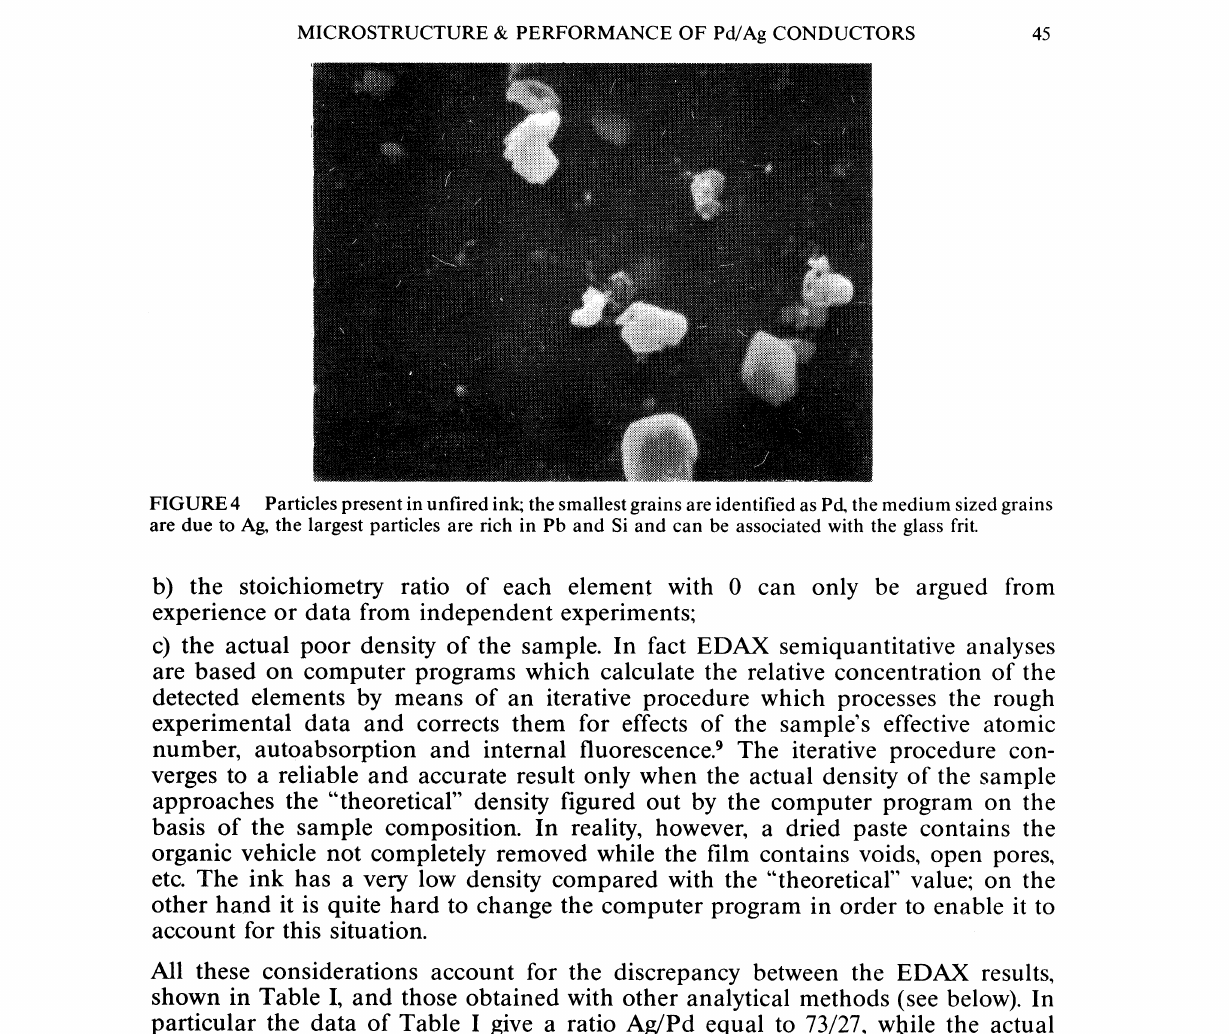
TABLE EDAX analysis.